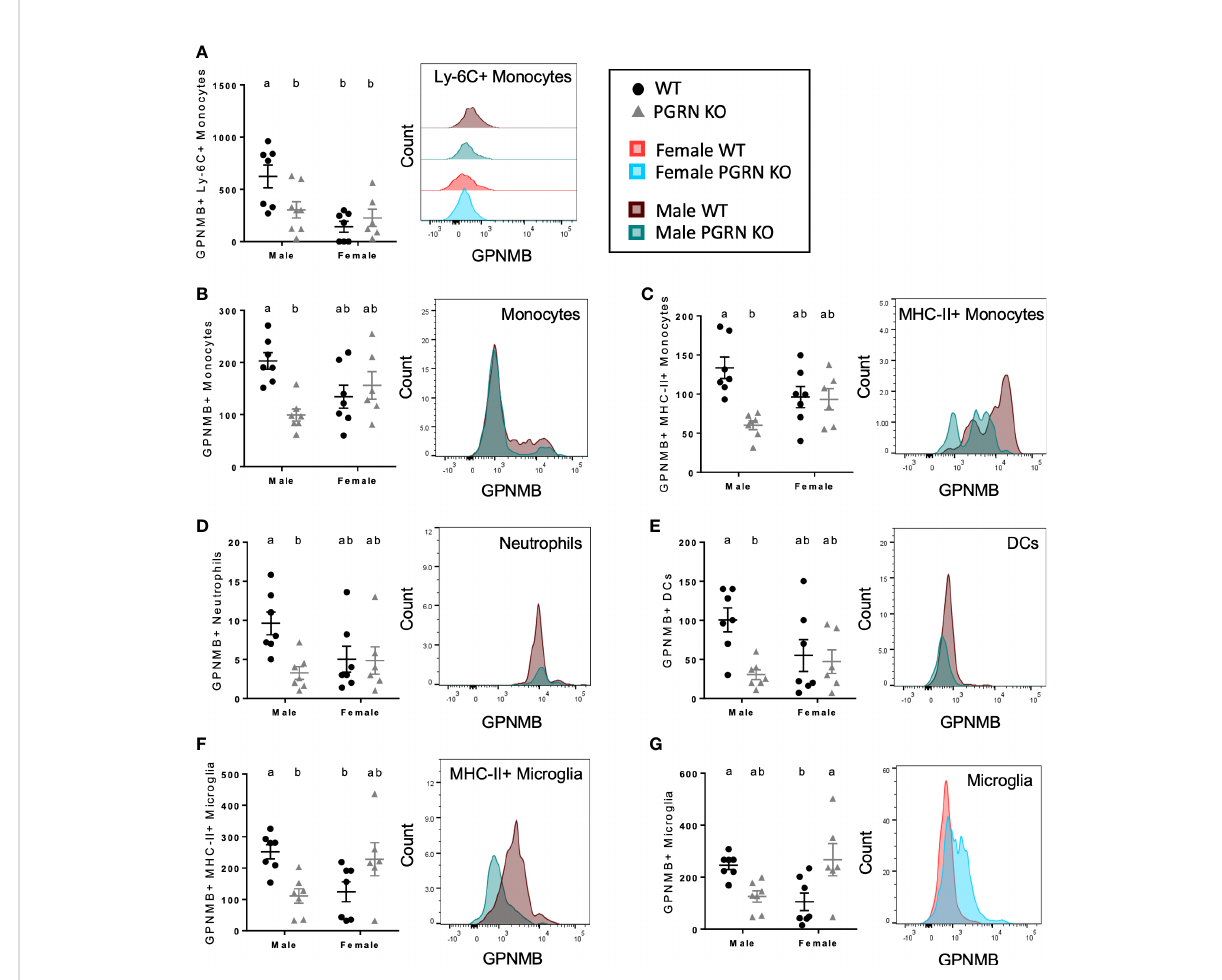
FIGURE 4 PGRN KO male mice have fewer GPNMB+ immune cells, while female PGRN KO mice increase GPNMB expression on microglia. Counts of (A) GPNMB + Ly-6C + monocytes in peripheral blood, and GPNMB + (B) monocytes, (C) MHC-II + monocytes, (D) neutrophils, (E) dendritic cells (DCs), (F) MHC-II + microglia, and (G) microglia in the brain from aged WT and PGRN KO mice (n=6-7) determined by fl ow cytometry; two-way ANOVA, sex effect p < 0.01 for (A) , genotype effect p < 0.05 for (B – E) , interaction p < 0.05 for all, Tukey ’ s post hoc . Histograms show distribution of fl uorescence intensity per cell. Letter(s) centered above groups re fl ect results of post hoc tests. Groups that do not share any letters are signi fi cantly different from one